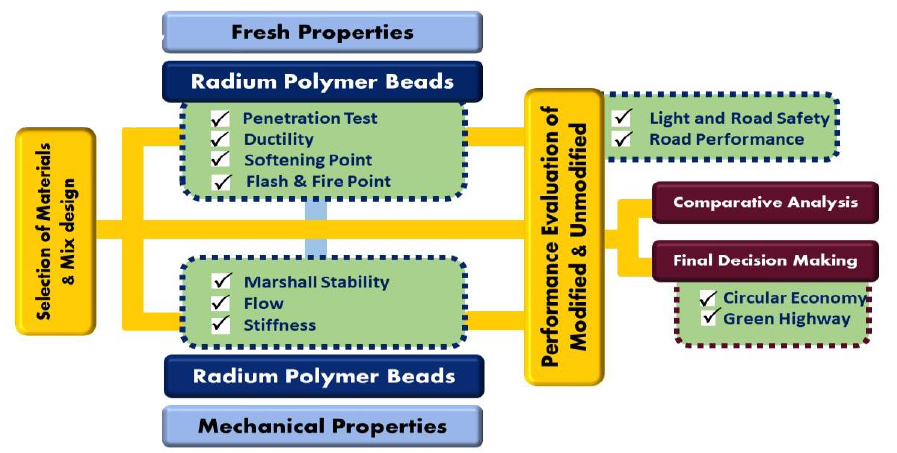
Figure 4. Complete research methodology (flow chart).